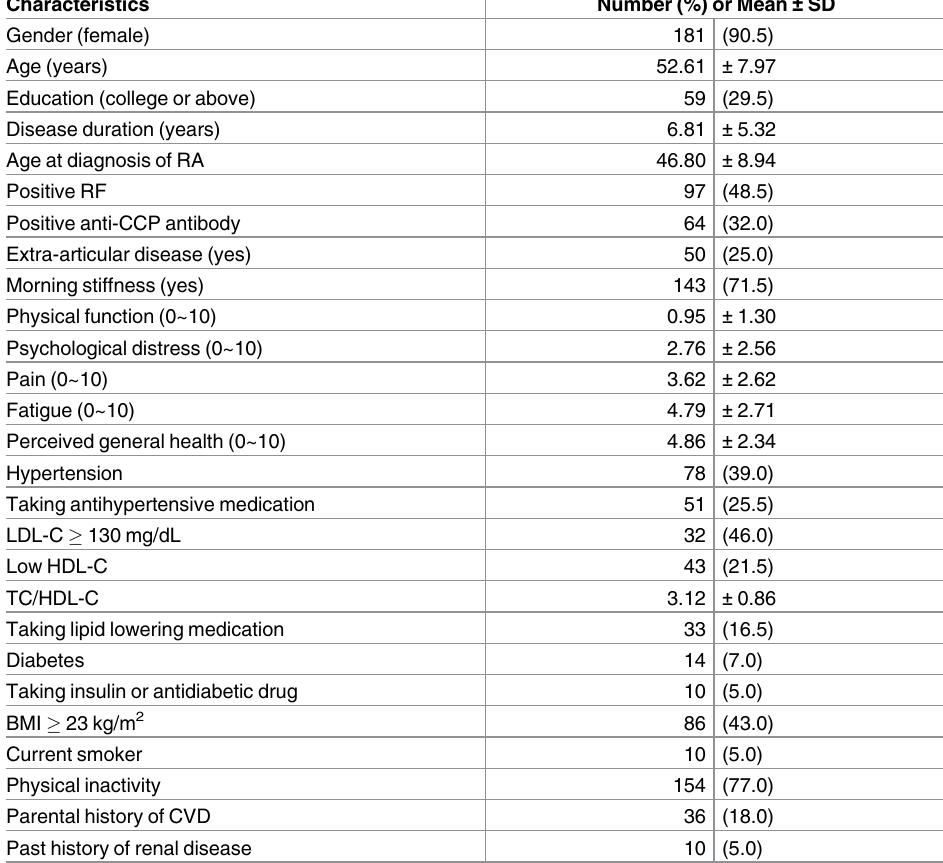
Table 1. Characteristics of participants ( n =